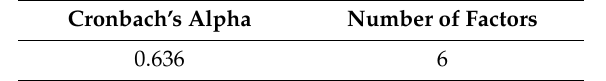
Table 8. Cronbach’s alpha factor for factors of the complexity of communication with